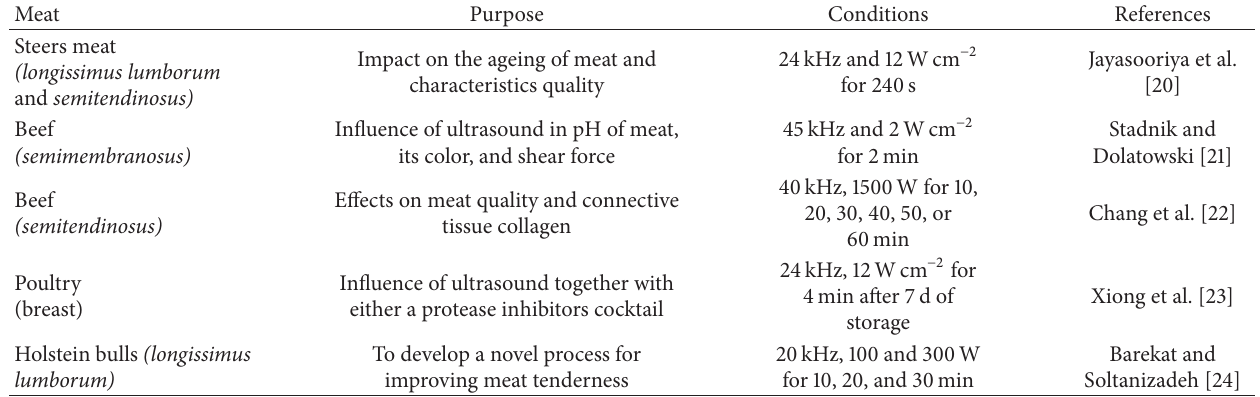
Table 2: Studies of ultrasound aimed to improve of meat